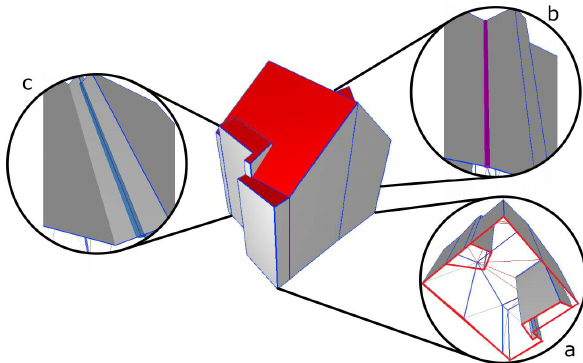
Figure 2. Example of a building model with quality deficits a) missing ground surface, internal polygons b) multiply used edges (an edge is shared by more than two faces) c) self-